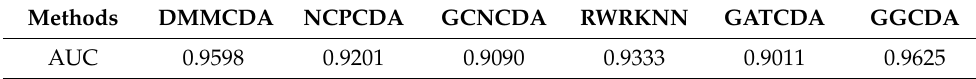
Table 3. The FFCV AUC values achieved by the various models.